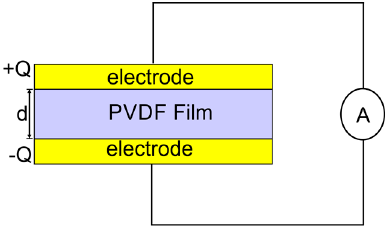
Figure 1. Schematic diagram of a capacitive sensor based on polyvinylidene fluoride (PVDF) film.